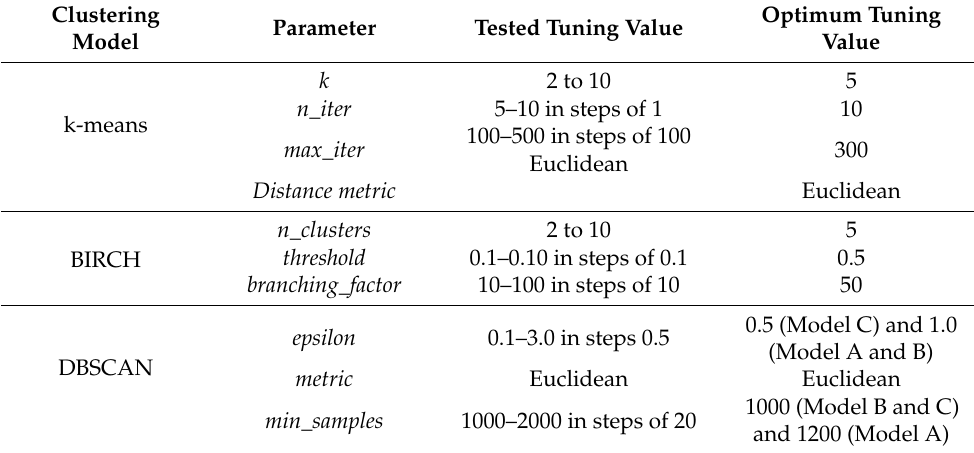
Table 7. Results of parameter